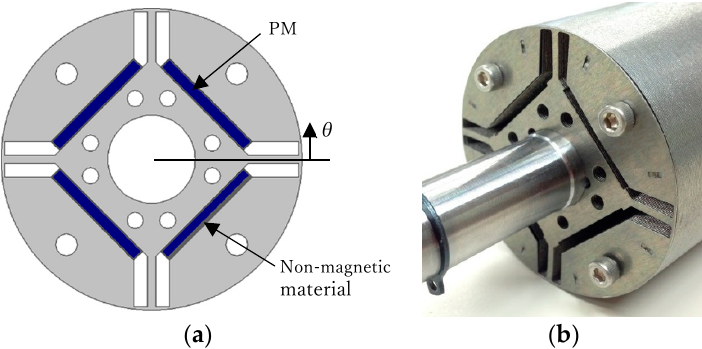
Figure 1. Rotor of the experimental interior permanent magnet synchronous motor (IPMSM): ( a ) rotor configuration; ( b ) photograph of rotor.